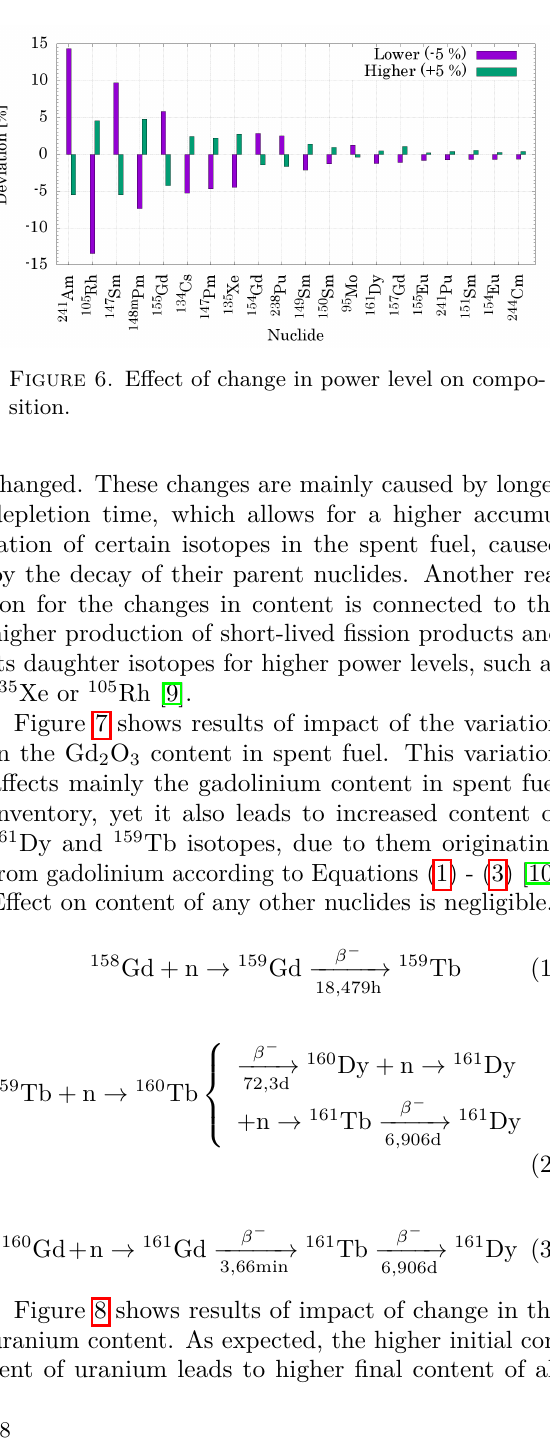
Figure 7. Effect of change in Gd composition.